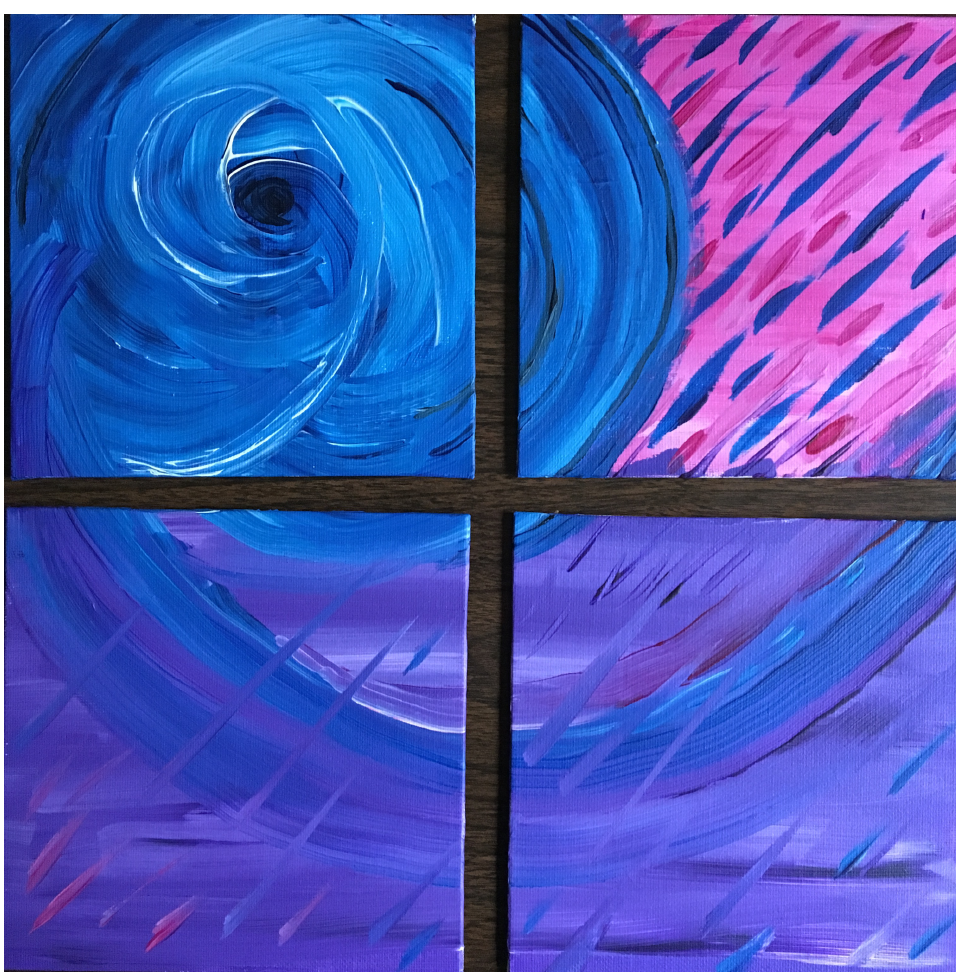
FFigigururee 1.1. PiecPieceses ofof